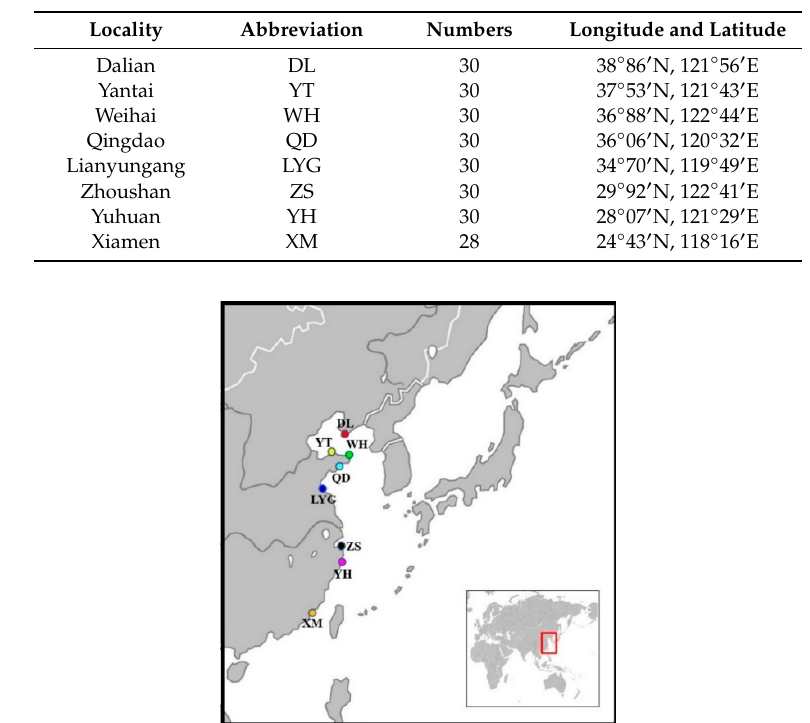
Table 1. Sample information in this paper.